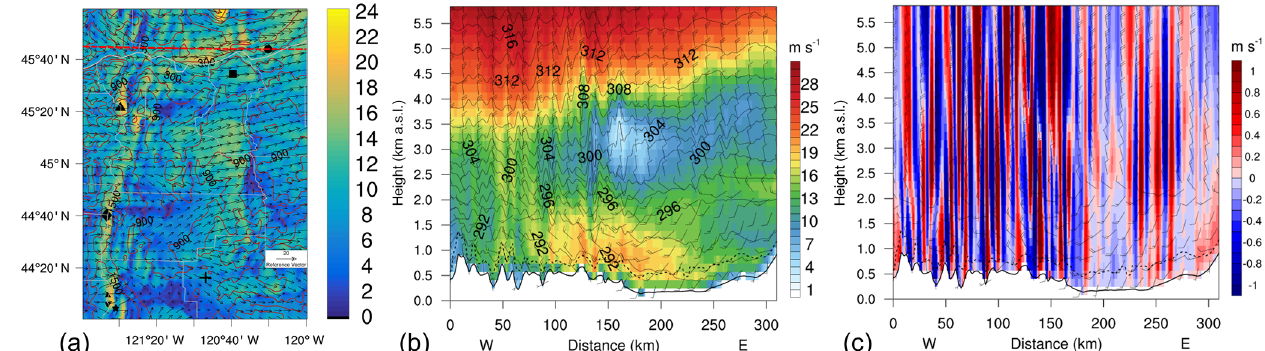
Figure 4. (a) Simulated wind field at 100ma.g.l. The big triangle, diamond, cross, square, and circle denote the locations of Mt. Hood, Mt. Jefferson, Prineville, the Wasco instrument site, and the wind farm, respectively. The Three Sisters and Broken Top located in lower-left corner are shown by smaller triangles and a star, respectively. Contours show terrain elevation every 300m. The red dashed line indicates the transect along which cross sections in (b) and (c) are taken. Note that the cross sections in (b) and (c) extend beyond the bounds of this plot. (b) Cross section of horizontal wind speed from west to east through the wind farm. Wind speeds are color-shaded; lines denote potential temperature [K]; the boundary layer top is dashed. (c) Cross section of vertical wind speeds through the wind farm at 04:00UTC on 24 September 2016.